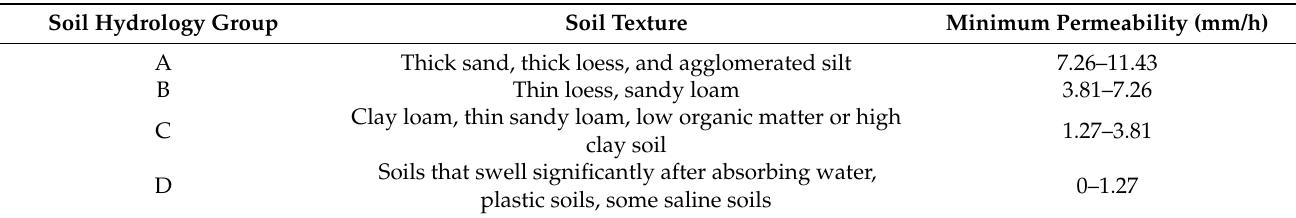
Table 1. SCS model soil hydrology group classification